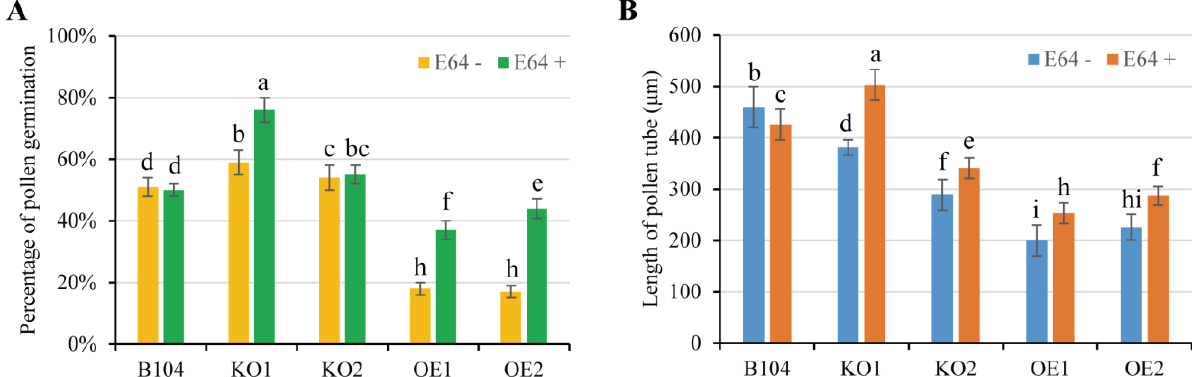
Figure 6. Comparison of pollen germination in vitro between WT and transgenic lines after 4 h incubation. ( A ) Percentage of pollen germination. ( B ) Length of pollen tube. Data represent means ± SD of three biological replicates. Significant differences are indicated with different letters ( p < 0.05, two - way ANOVA).